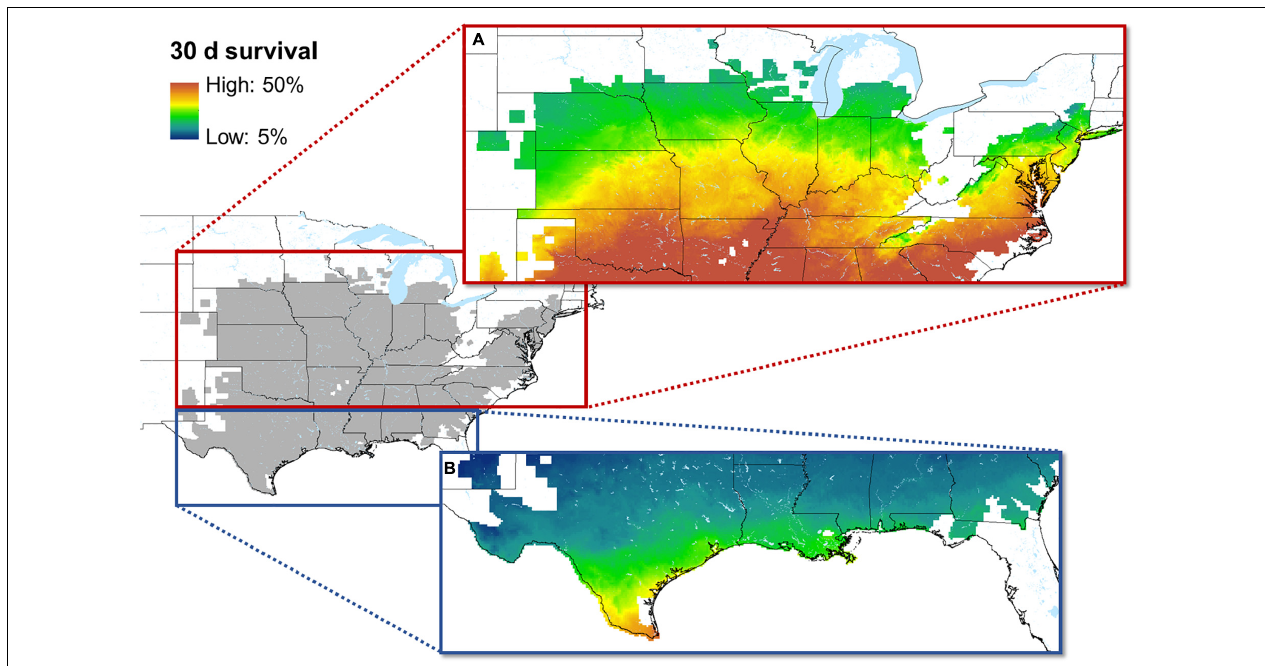
FIGURE 4 | The historic range of A. crepitans is shown in gray on the map at left. Enlarged on the right are maps of predicted 30 day survival for A. crepitans frogs infected with Bd just prior to breeding. In the central and northern part of the frog’s range (A) , the model is for the time between emergence and the start of breeding. In the south (where A. crepitans are known to remain active year-round), the model is for the coldest part of the year (January), which precedes a breeding pulse in